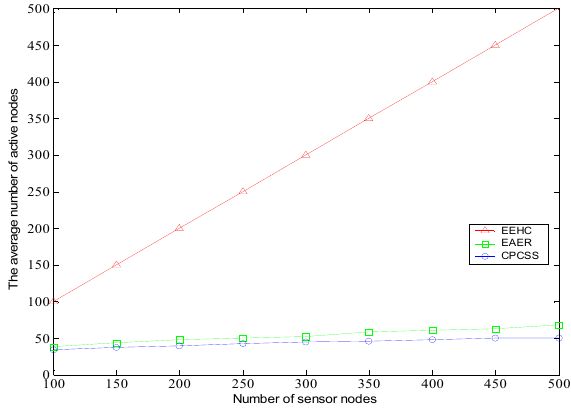
Figure 12. The average number of active nodes versus number of sensor nodes.